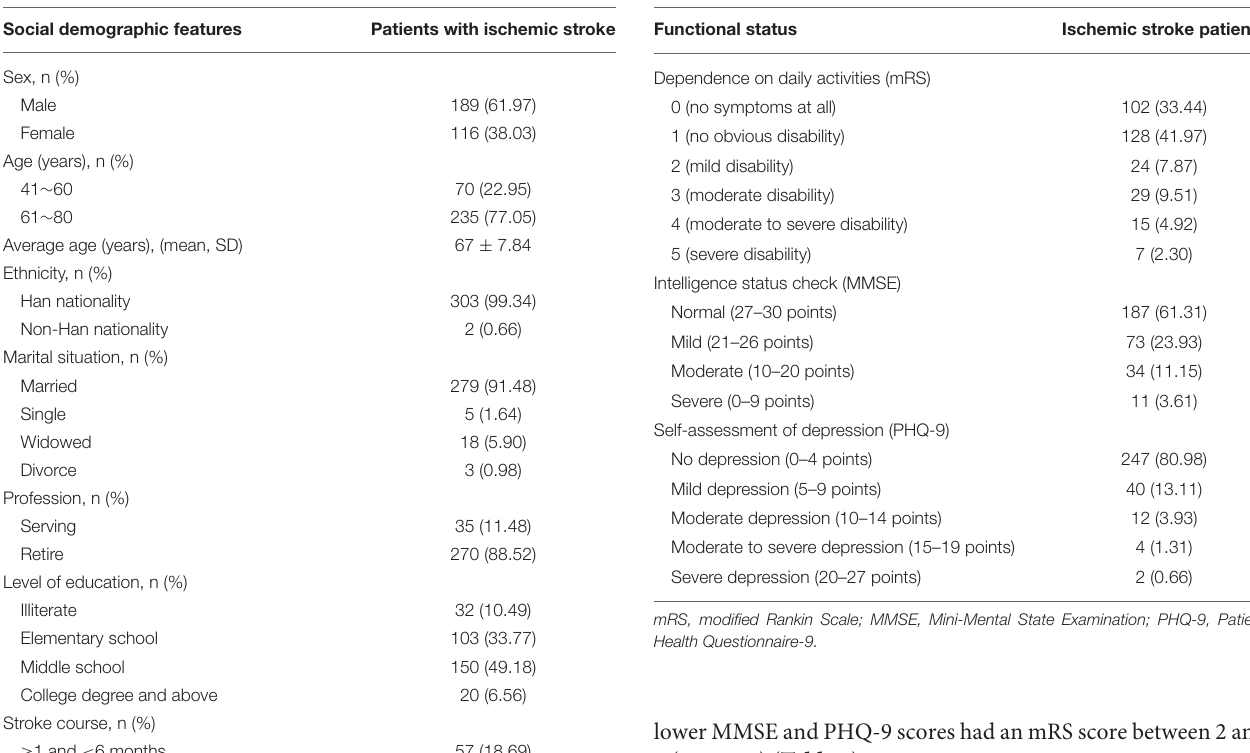
TABLE 3 | Health status of ischemic stroke patients ( n =